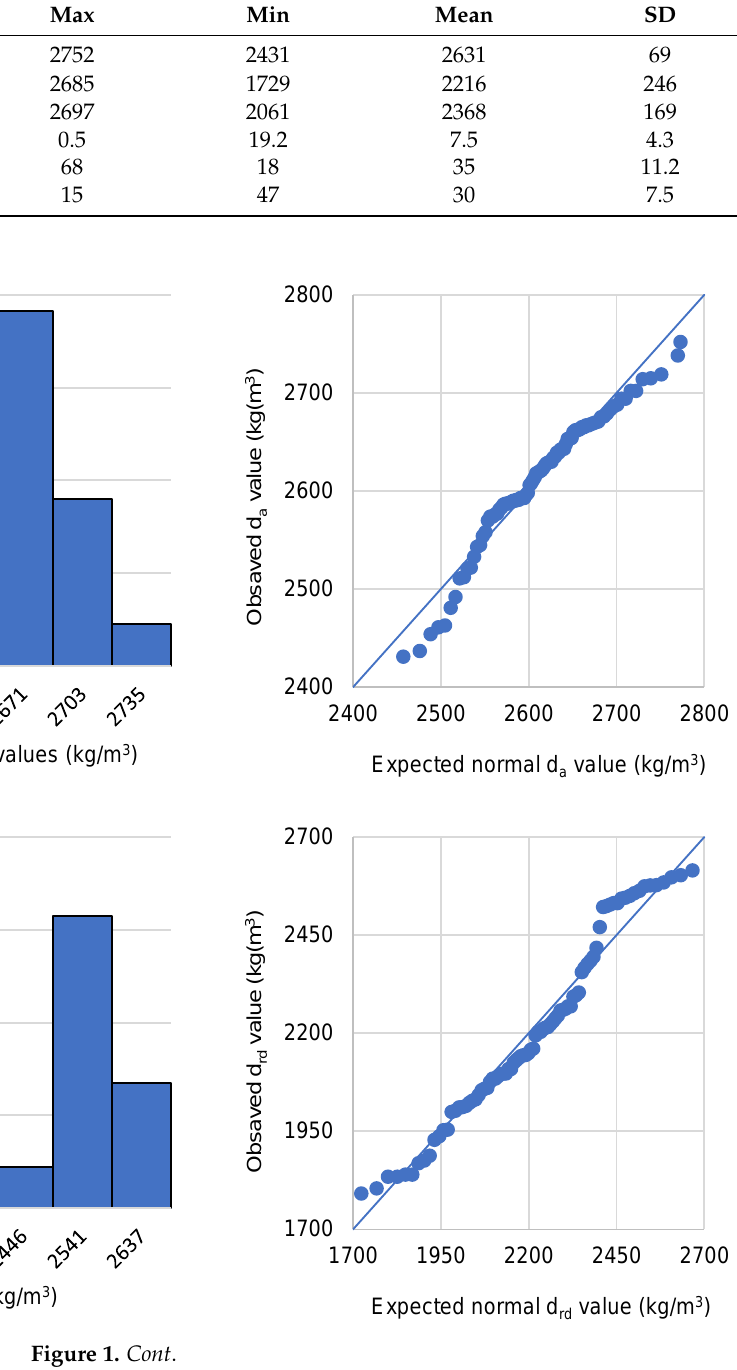
Table 2. Statistics of the properties studied on the RA samples.